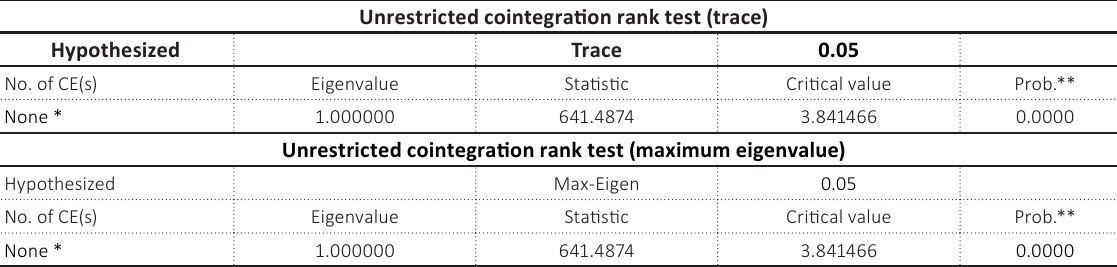
Source: Author’s